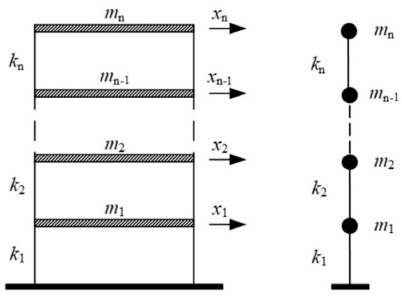
Figure 2. n-DOF structure model.